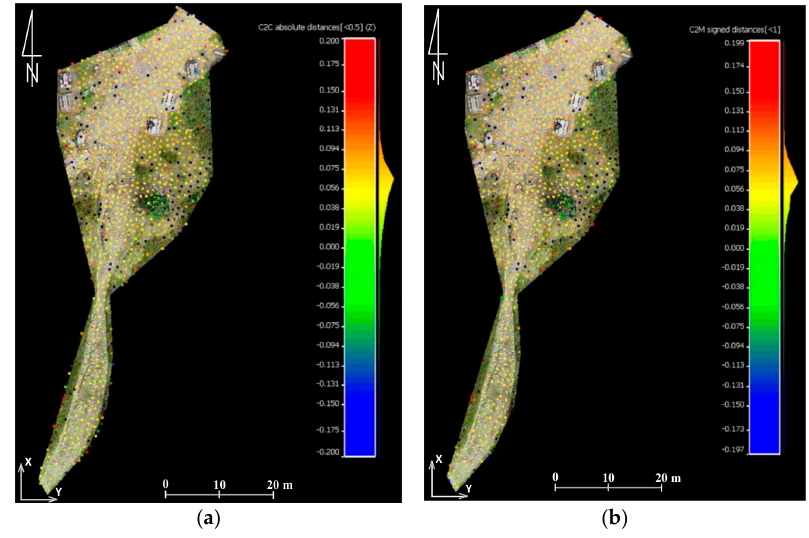
Figure 9. Results of comparing the point cloud from TLS with the point cloud from the UAV ( a ) and mesh model from the UAV ( b ) in certain points for the first test field (source: authors’ own study) (the units given are in